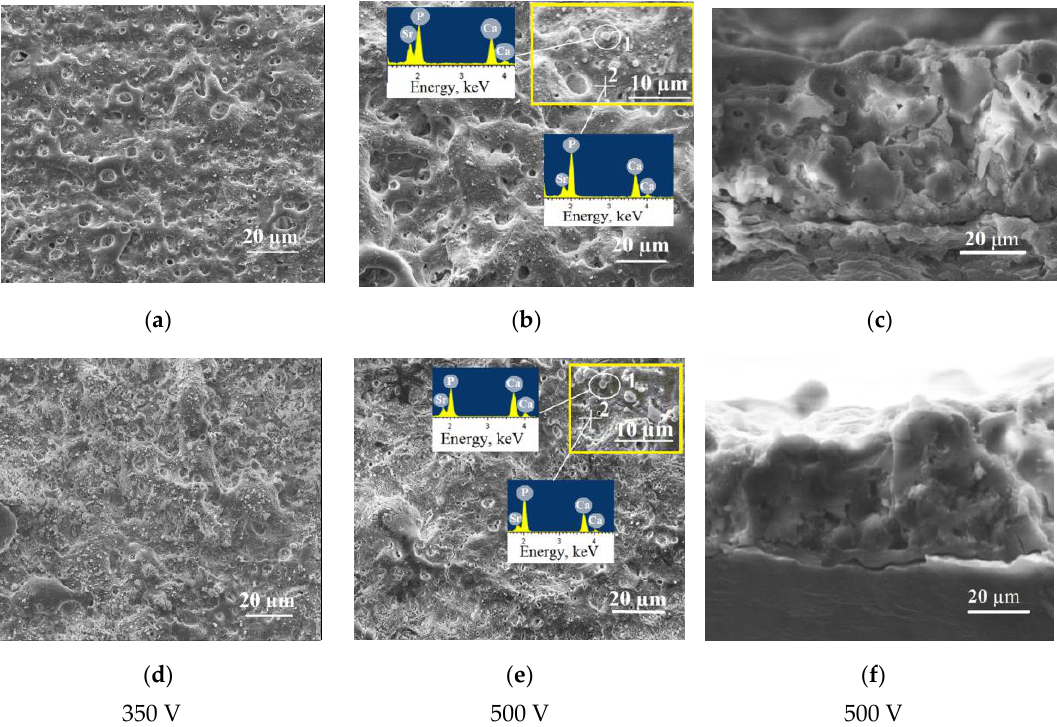
Figure 2. Scanning electron microscope (SEM) images of the surface ( a , b , d , e ) and cross-section ( c , f ) of the Sr-HA ( a – c ) and Sr-TCP ( d – f ) deposited at 350 V ( a , d ) and 500 V ( b , c , e , f ). SEM image of the coating surface with higher magnification is presented in the yellow frame.